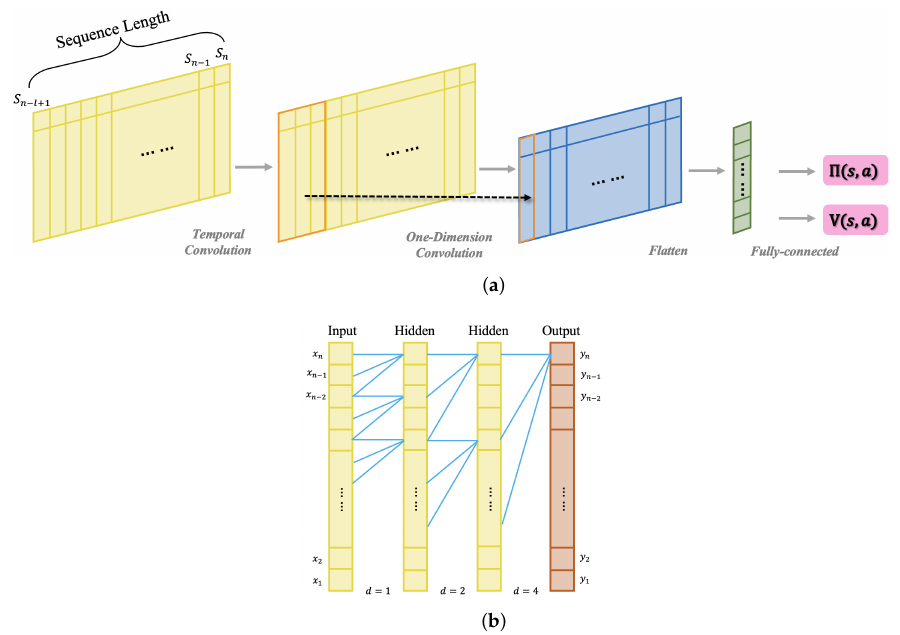
Figure 3. Network architecture: ( a ) TCN enabled A3C; ( b ) temporal convolutional